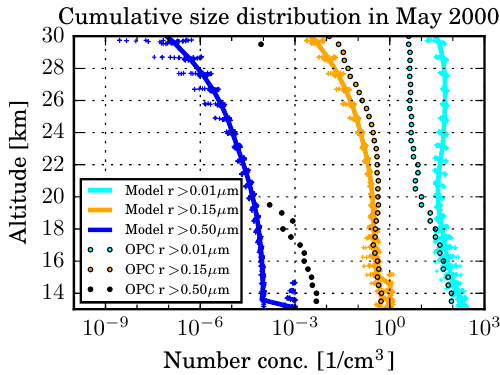
Figure 5. Vertical profile of the cumulative aerosol number con- centration (cm − 3 ) for three channels ( r > 0 . 01µm in light blue, r > 0 . 15µm in orange, and r > 0 . 5µm in dark blue) at Laramie, Wyoming (41 ◦ N, 105 ◦ W), in the style of Sekiya et al. (2016). Solid lines show the modelled monthly mean, while the crosses indicate the range of daily mean concentrations within that month. Optical particle counter (OPC) measurements from Deshler et al. (2003) are shown as symbols connected by dashed lines.